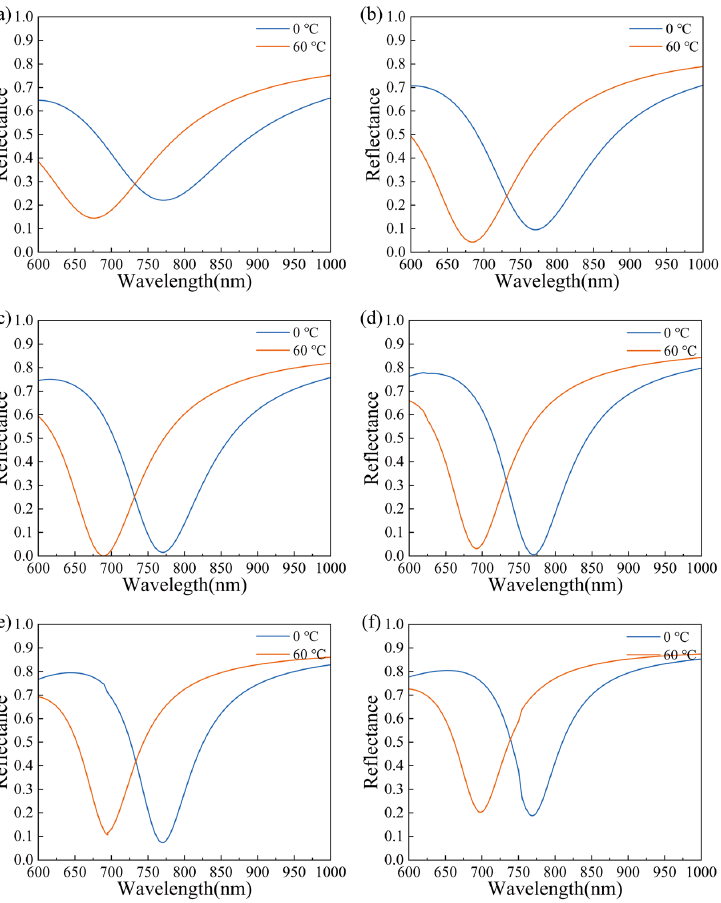
Figure 2. The reflectance curve of pure gold SPR sensors at different thicknesses of gold film: ( a ) 35 nm, ( b ) 40 nm, ( c ) 45 nm, ( d ) 50 nm, ( e ) 55 nm, and ( f ) 60 nm.